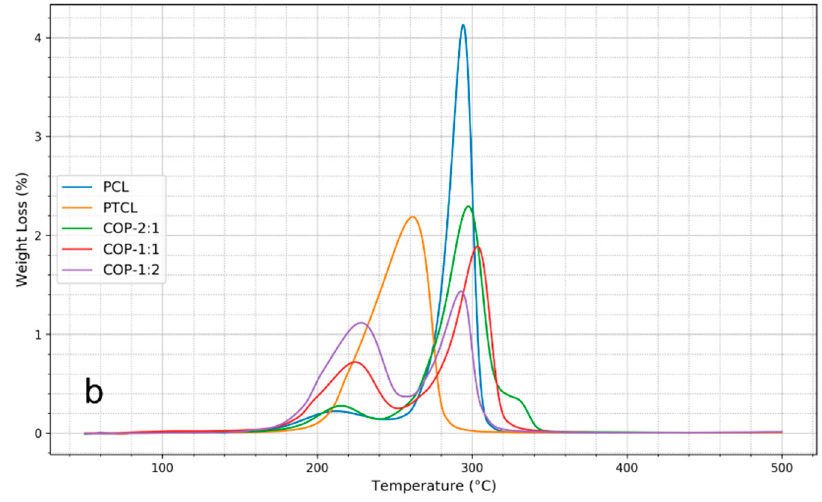
Figure 5. ( a ) Weight loss and ( b ) DTG curves of homo- and copolymers of CL and TCL.